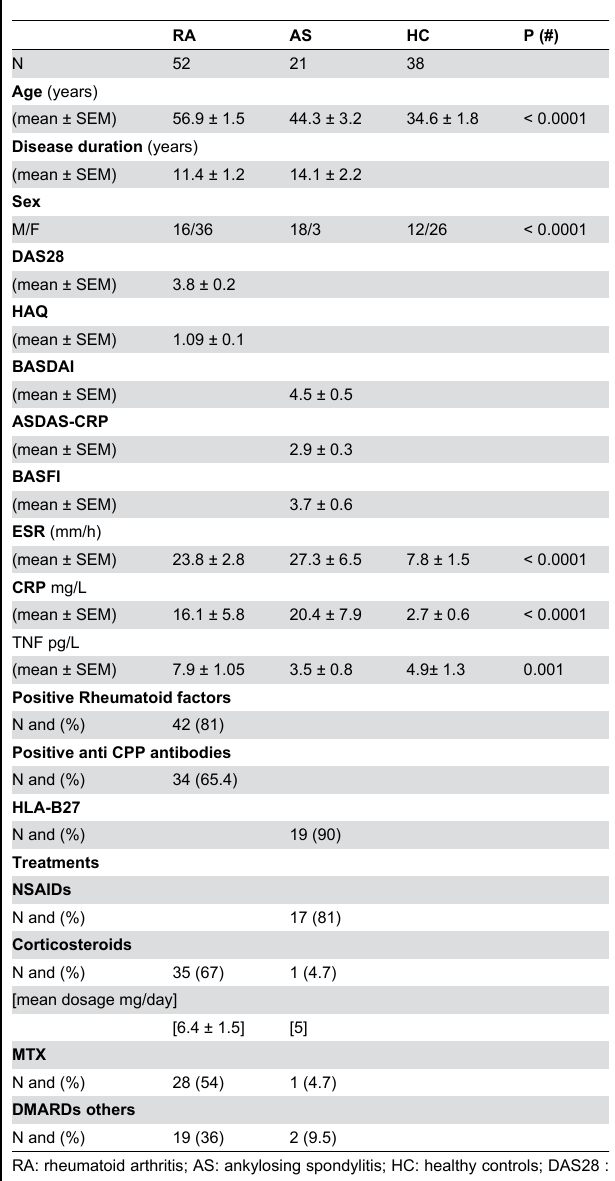
Table 2. Histone acetyl transferase (HAT) and histone deacetylase (HDAC) activities in PBMC nuclear extracts from patients with rheumatoid arthritis, ankylosing spondylitis and healthy